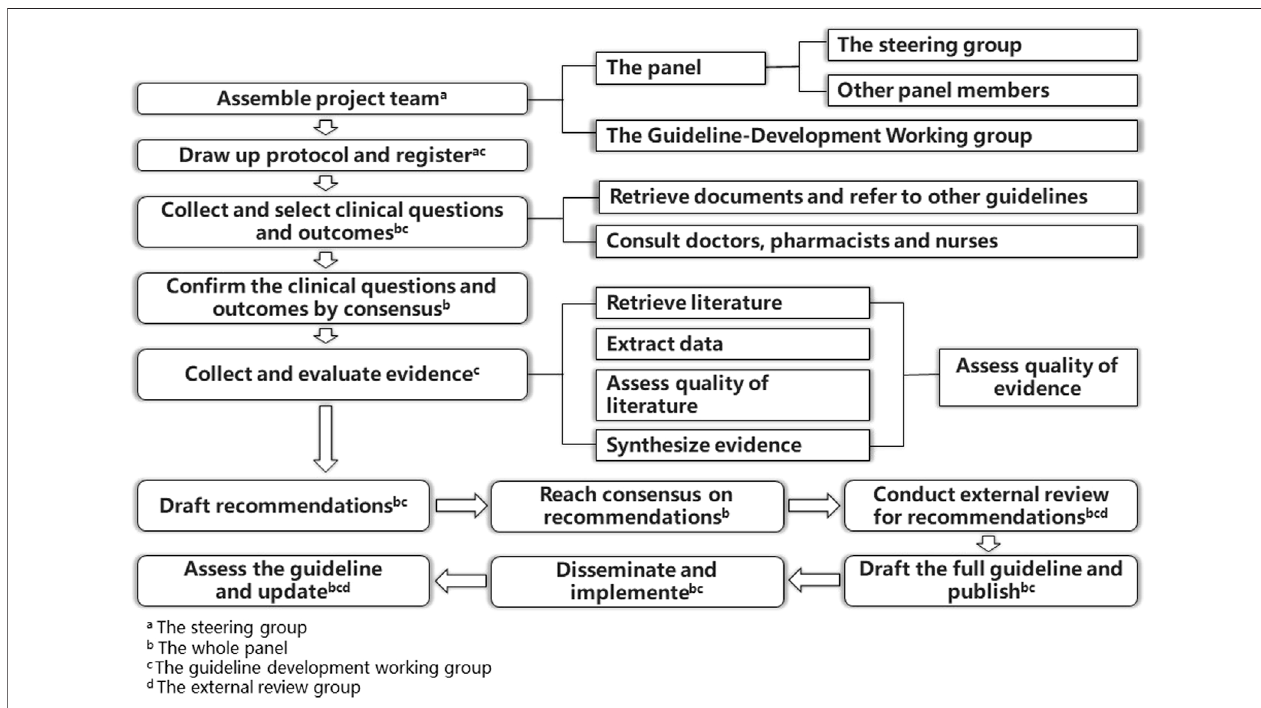
FIGURE 1 | Guideline development